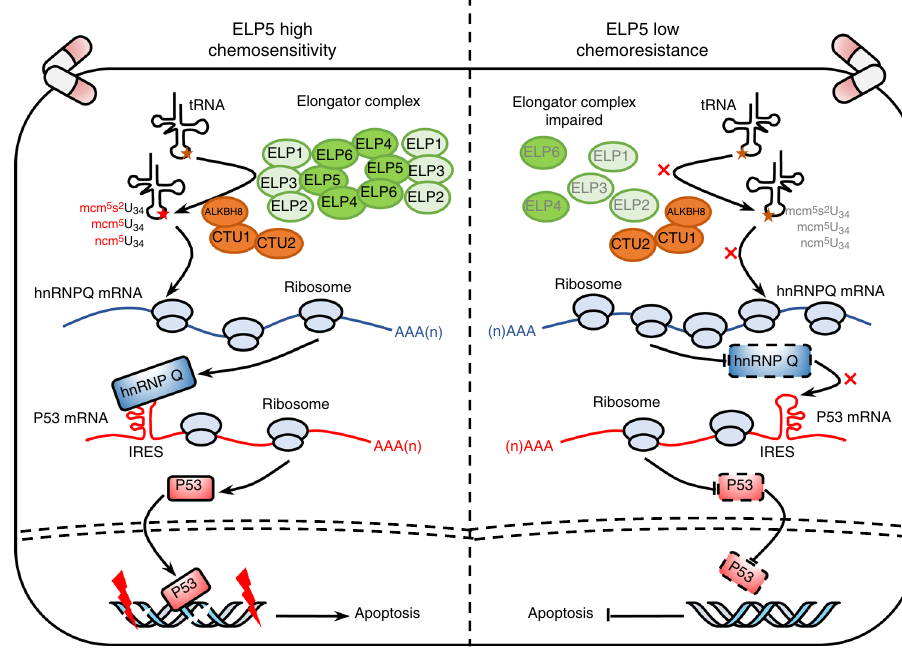
Fig. 8 A proposed model of action by which ELP5 depletion impairs gemcitabine-induced apoptosis in GBC